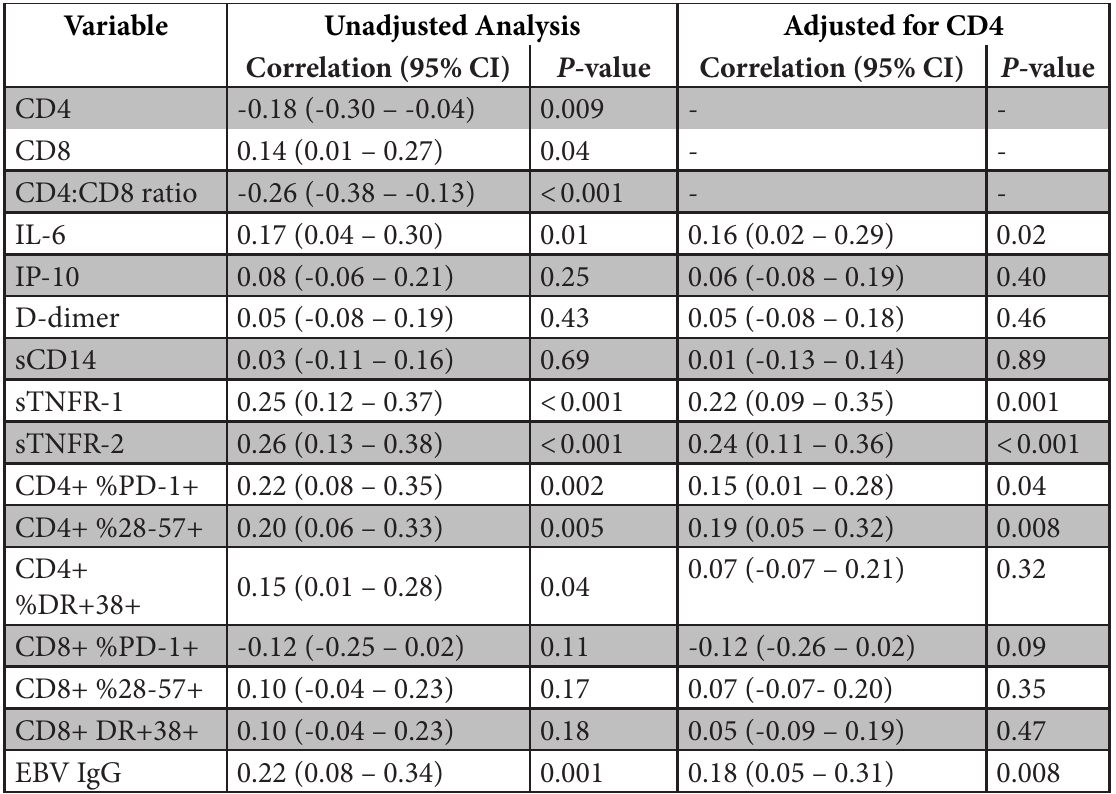
Table 3. Correlations between CMV IgG Level and Soluble and Cellular Immune Markers at Year 1 Among